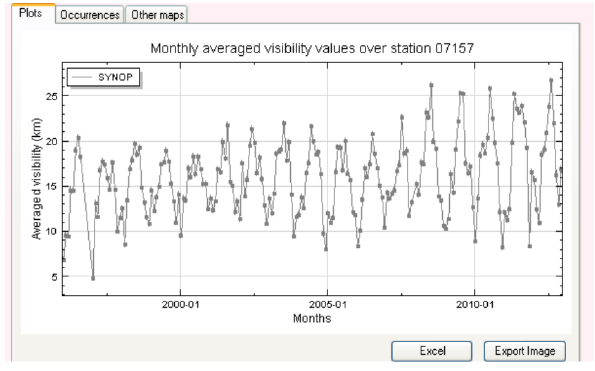
Figure 9. Monthly mean visibility values (km) over Charles de Gaulle airport for period varying from January 1996 to Au- gust